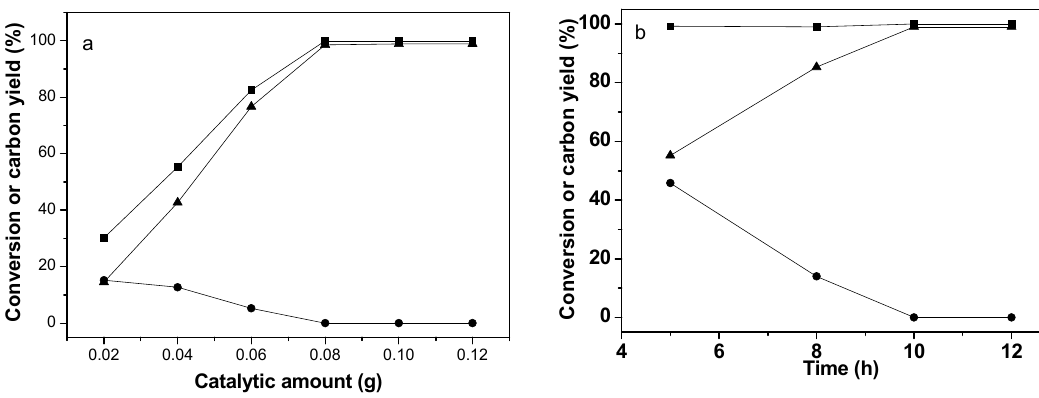
Figure 5. Cyclopentanone conversion ( ■ ) and carbon yields of 2,5-bis(furan-2-ylmethyl)-cyclopentanone ( ▲ ) and 2,5-bis(2-furylmethylidene)-cyclopentanone ( ● ) over the Pd/C-CaO catalyst. Experimental conditions: 423 K, 10 h, and 4.0 MPa H 2 ; 0.84 g cyclopentanone (10 mmol), 1.92 g furfural (20 mmol), 0.08 g Pd/C-CaO catalyst were used in the tests. ( a ) The effect of catalyst dosage. ( b ) The effect of time.